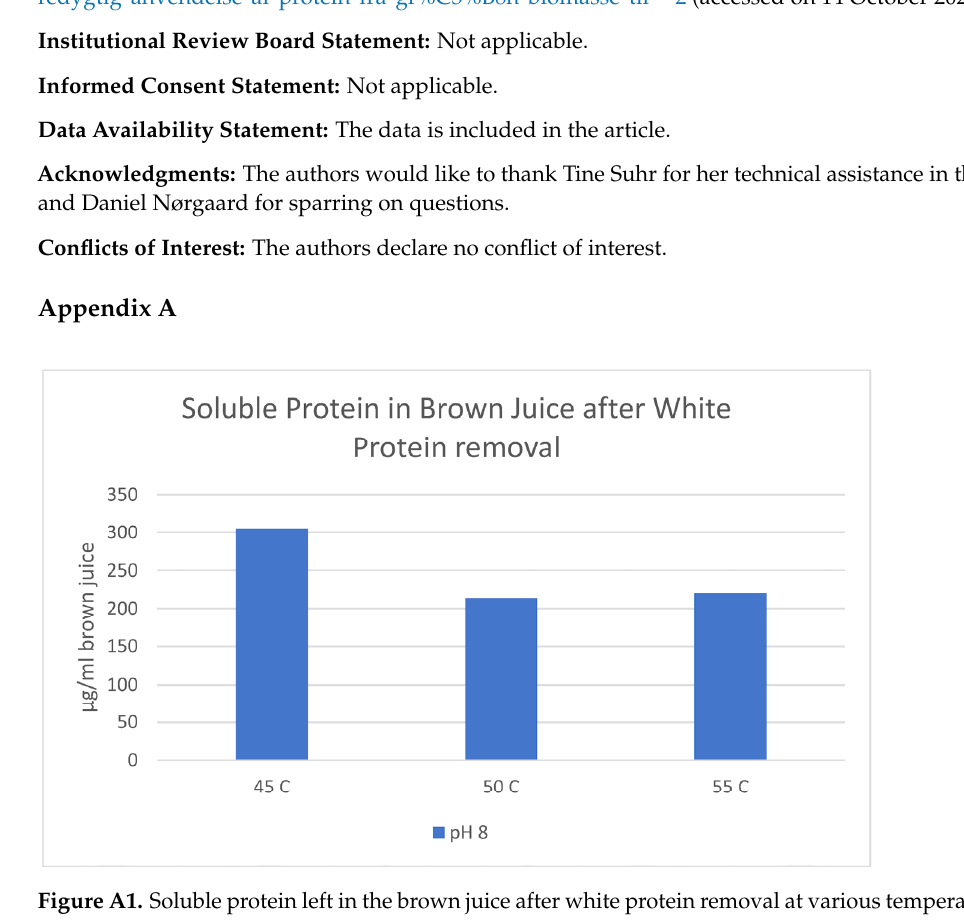
Table A1. Particle size distribution of WS after crushing in mortar and pestle, then sieving (Plan- sifter MLUA, Bühler, Beilngries, Germany, n = 1). Size (mm)